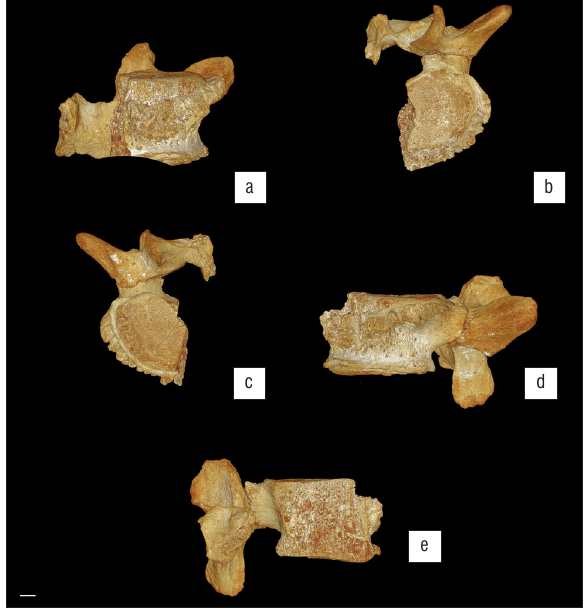
Figure 3: Three-dimensional volume rendered micro-CT views of the L5 vertebra of StW 431: (a) anterior, (b) superior, (c) inferior, (d) left lateral and (e) right lateral. Note the osteophytic formation on the superior and inferior endplate margins, as well as the anterior surface of the body in midline.